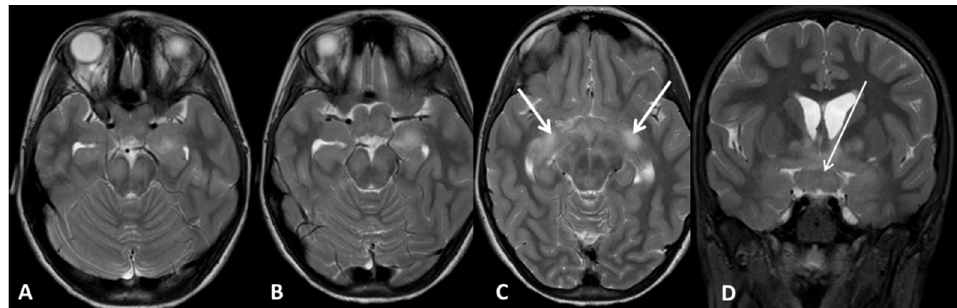
Figure 3. Optic pathways glioma 3B H+ (Subject 16 OPG). Brain MRI. ( A , B , C ) Axial T2 weighted images (w.i.); ( D ) coronal T2 w.i. with fat-suppression. All the panels show enlargement of the chiasm (arrow in D) and retrochiasmatic visual pathways with abnormal signal intensity (arrows in C). OPG: Optical pathways glioma; MRI: Magnetic resonance imaging.